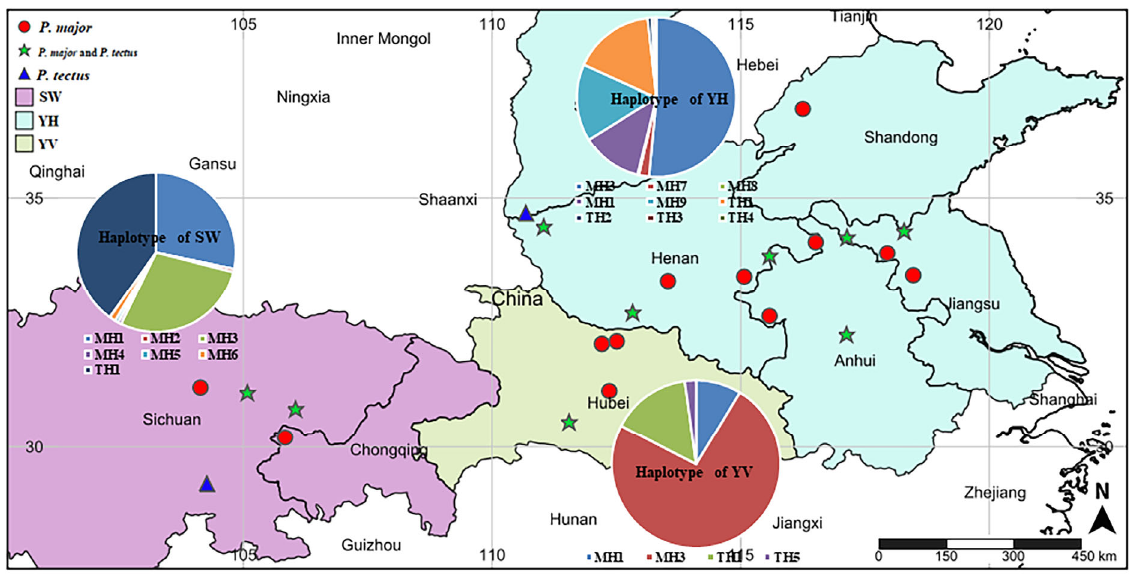
Figure 2. Location map of the studied wheat populations of P. major and P. tectus in Southwestern China (SW), Middle and Lower Yangtze Valleys (YV), and Yellow and Huai Valleys (YH), which are the three major winter wheat areas of China. The picture was created using the online website SimpleMappr (h tt ps://www.simplemappr.net accessed on 16 December 2022) with latitude and longitude data. The haplotype network diagram was created in PowerPoint. Table 1. Sample collection information for P. major and P. tectus used in this study.